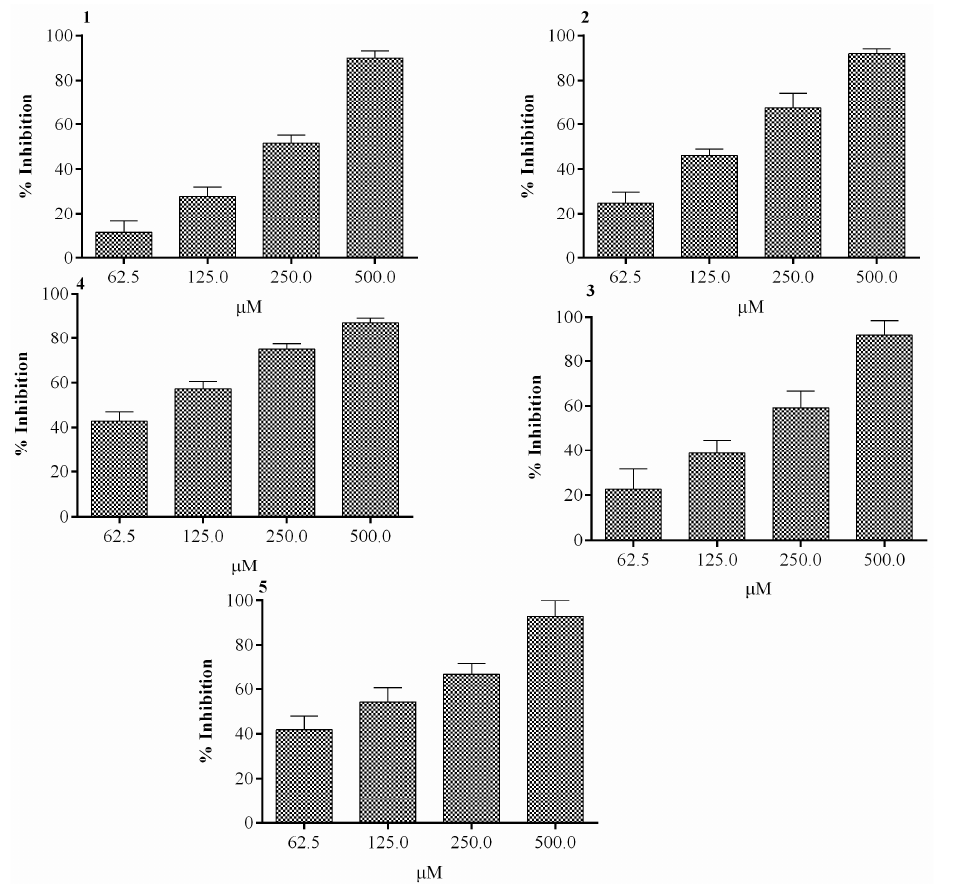
Figure 2. Per cent inhibition of test compounds 1 – 5 from Dryopteris cycadina against α -glucosidase at various concentrations. Values are expressed as mean ± SEM of three independent readings.